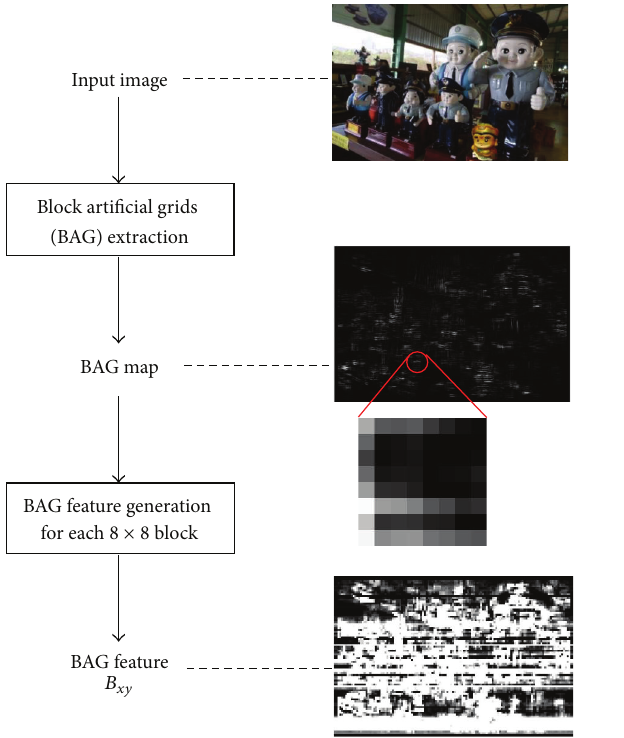
Figure 4: Flowchart of proposed method: BAG feature generation.